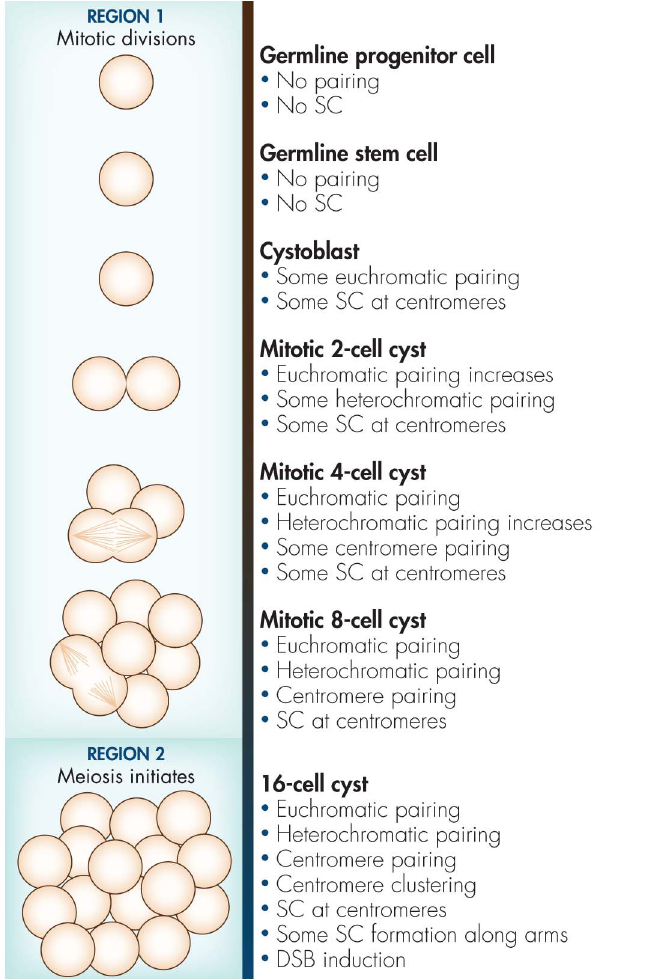
Figure 1. Diagram of events in premeiotic germline with respect to autosome pairing, centromere clustering, and SC formation based on the results from Joyce et al. [ 2 ] and Christophorou et al. [ 1 ] . (We thank Angela Seat for figure and editorial assistance.)